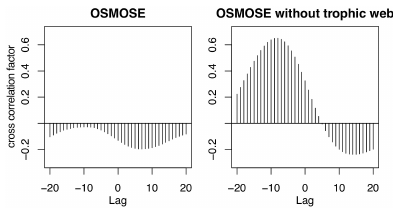
FIGURE A2 Cross correlation between the yearly running means of plankton forcing and mesopelagic fi sh biomass in OSMOSE simulations with monthly